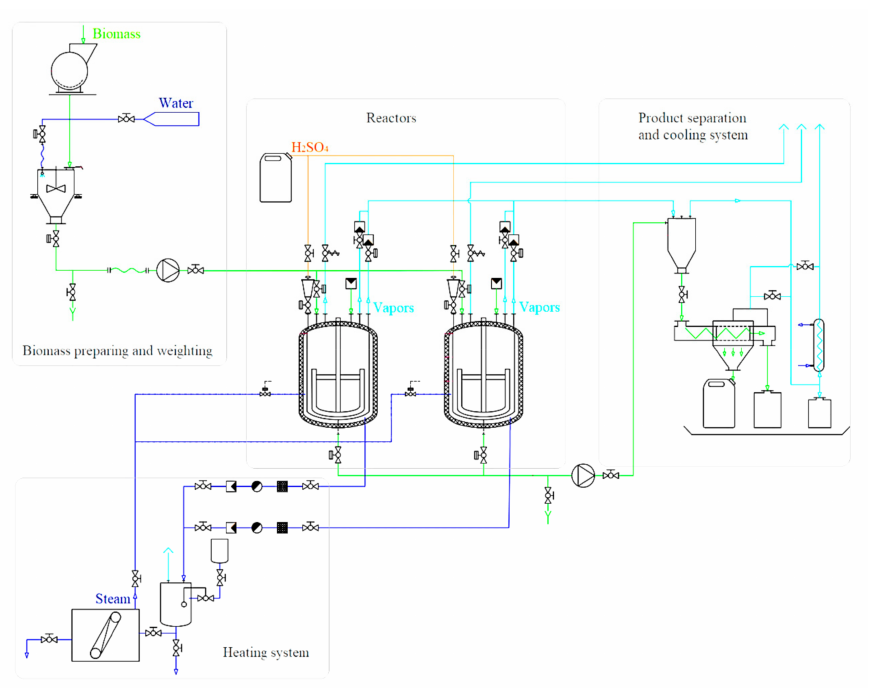
Figure 3. Diagram of an installation for the processing of beet pulp and beet leaves to furfural on a quarter-technical scale.